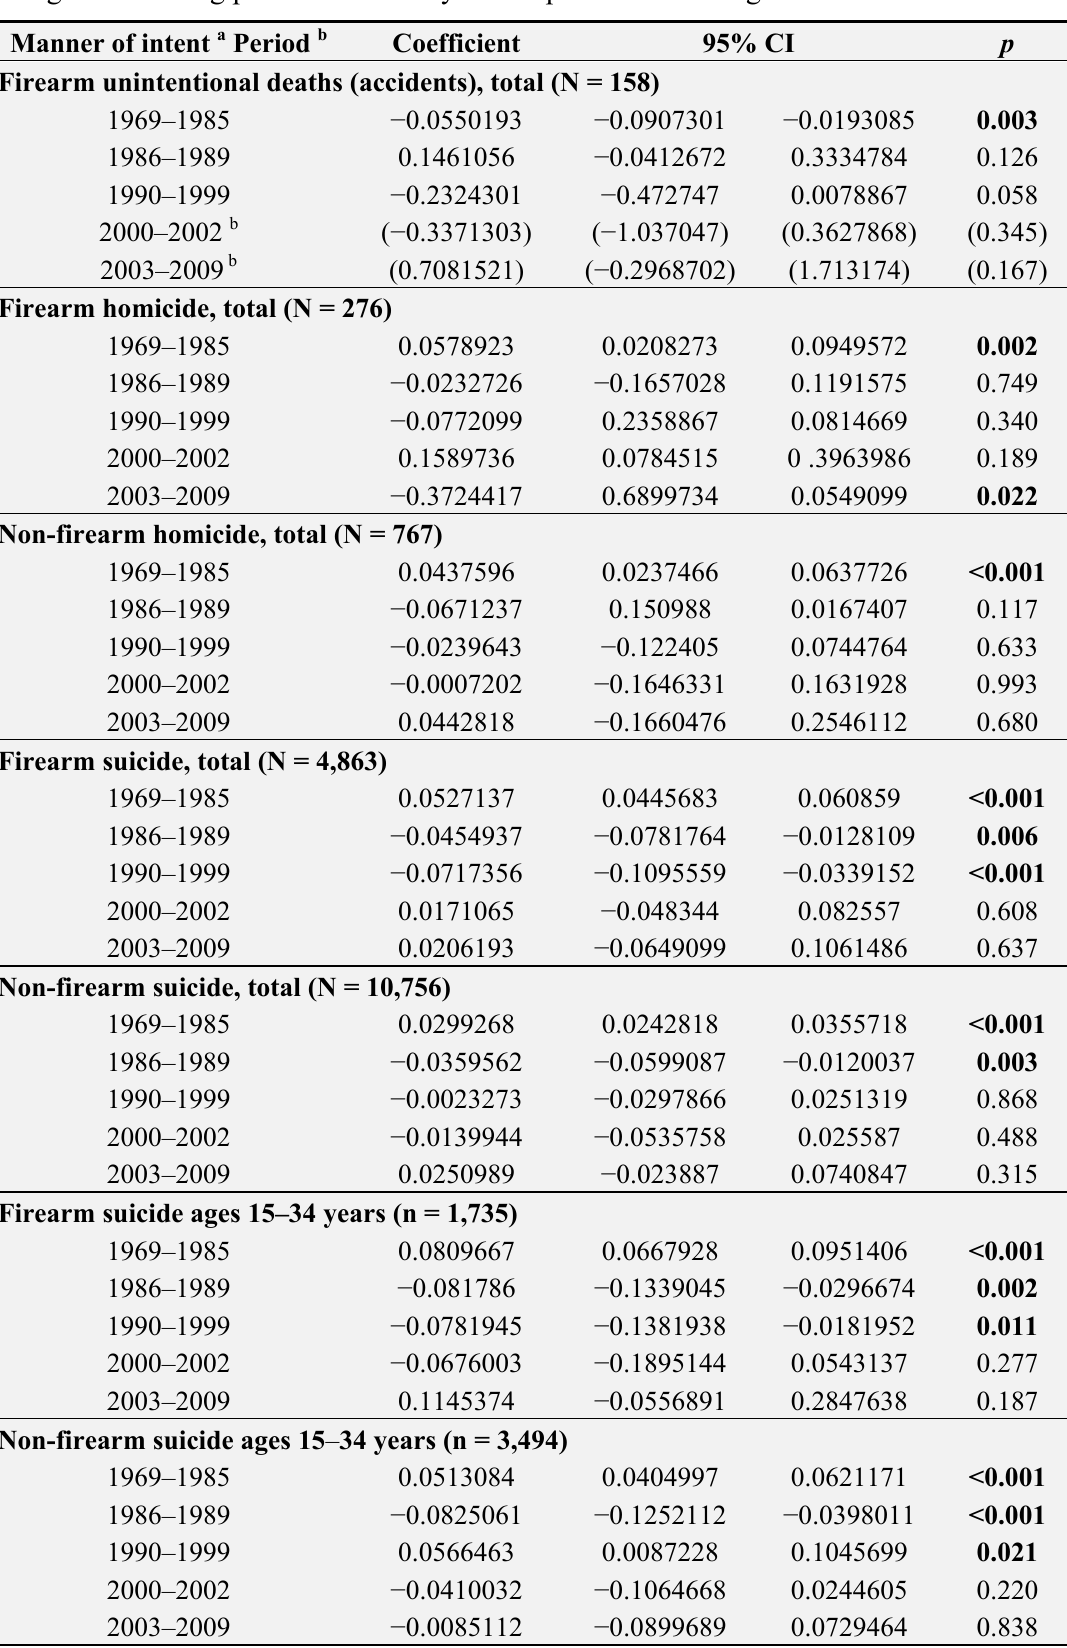
Table 5. Results of piecewise Poisson regression of the difference in trends of death rates among males during periods defined by four separate firearm regulations a